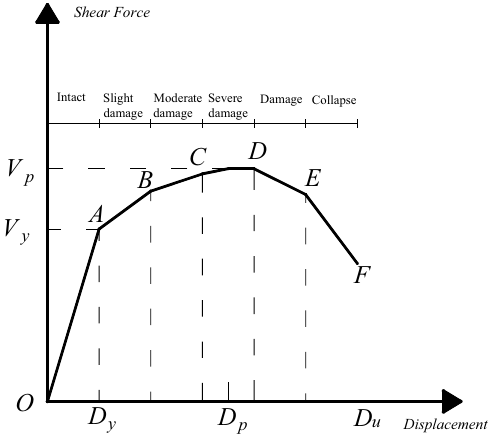
Figure 2. Force–displacement curve of reinforced concrete structure.